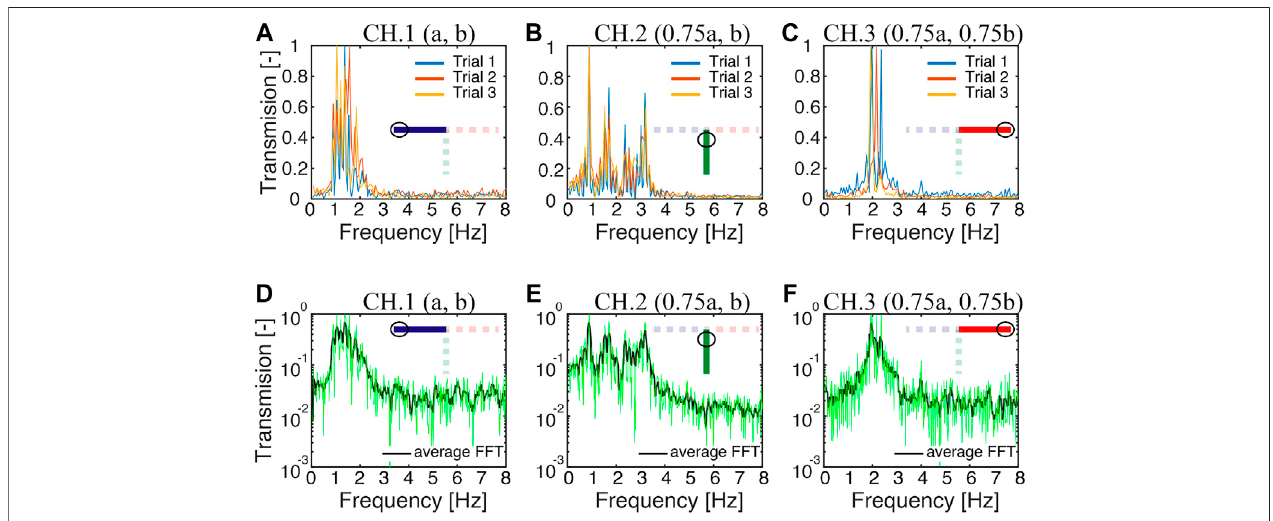
FIGURE 4 | Chirp signal transmission through the demultiplexer. Fast Fourier transform of the displacement of the central meta-atom and their average over three trialsfor (A, D) channel1, (B,E) channel 2,and (C,F) channel3.Theinputchannelisexcited withachirpsignalbetween0.1 ‒ 10Hz. Theinsetshowsthecorresponding channel in the T-shaped demultiplexer.